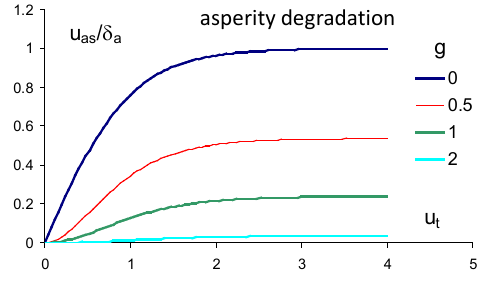
Figure 14: Evolution of asperity profile due to wear